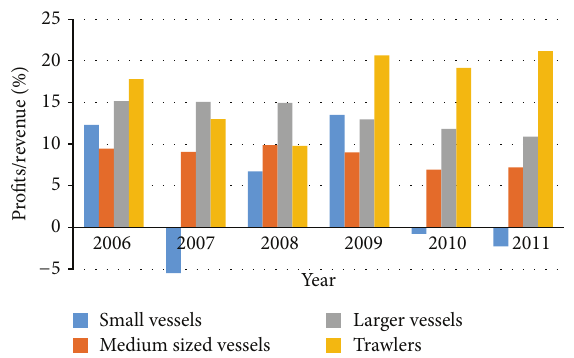
Figure 4: Profits as a ratio of total revenue by vessel